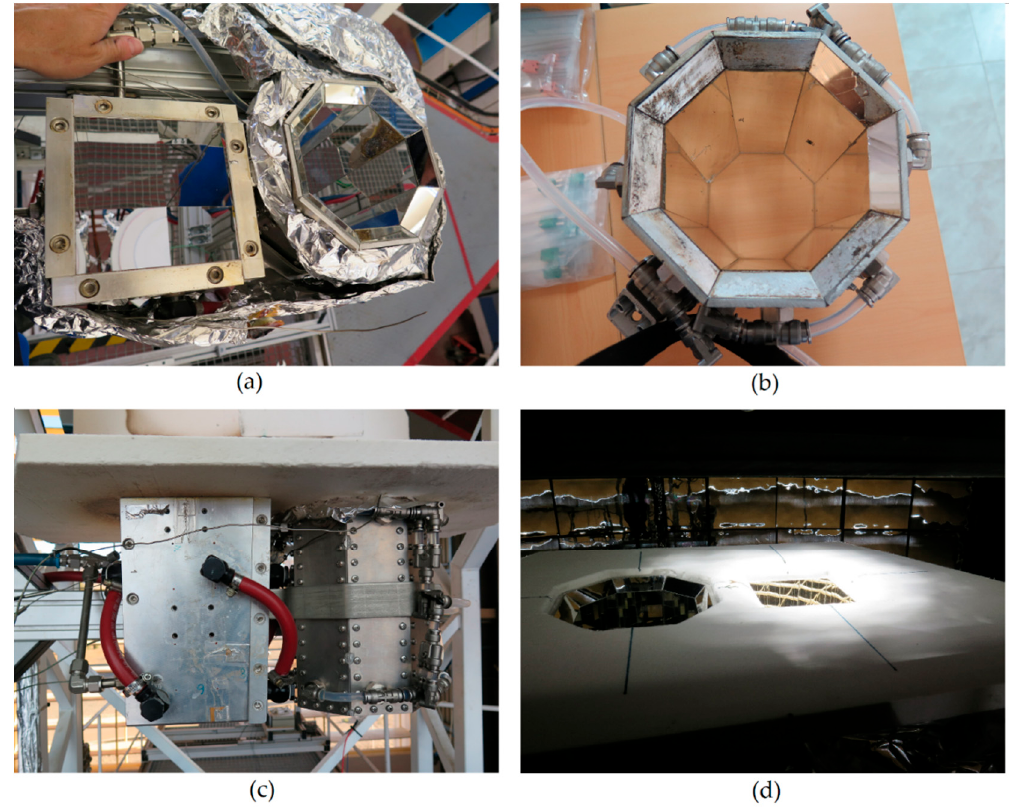
Figure 2. Radiation homogenisers with 4 and 8 sides, seen from top ( a , b ), from the side ( c ) and when illuminated, protected with Zirconia felt ( d ). Both homogenisers operate under active water cooling.